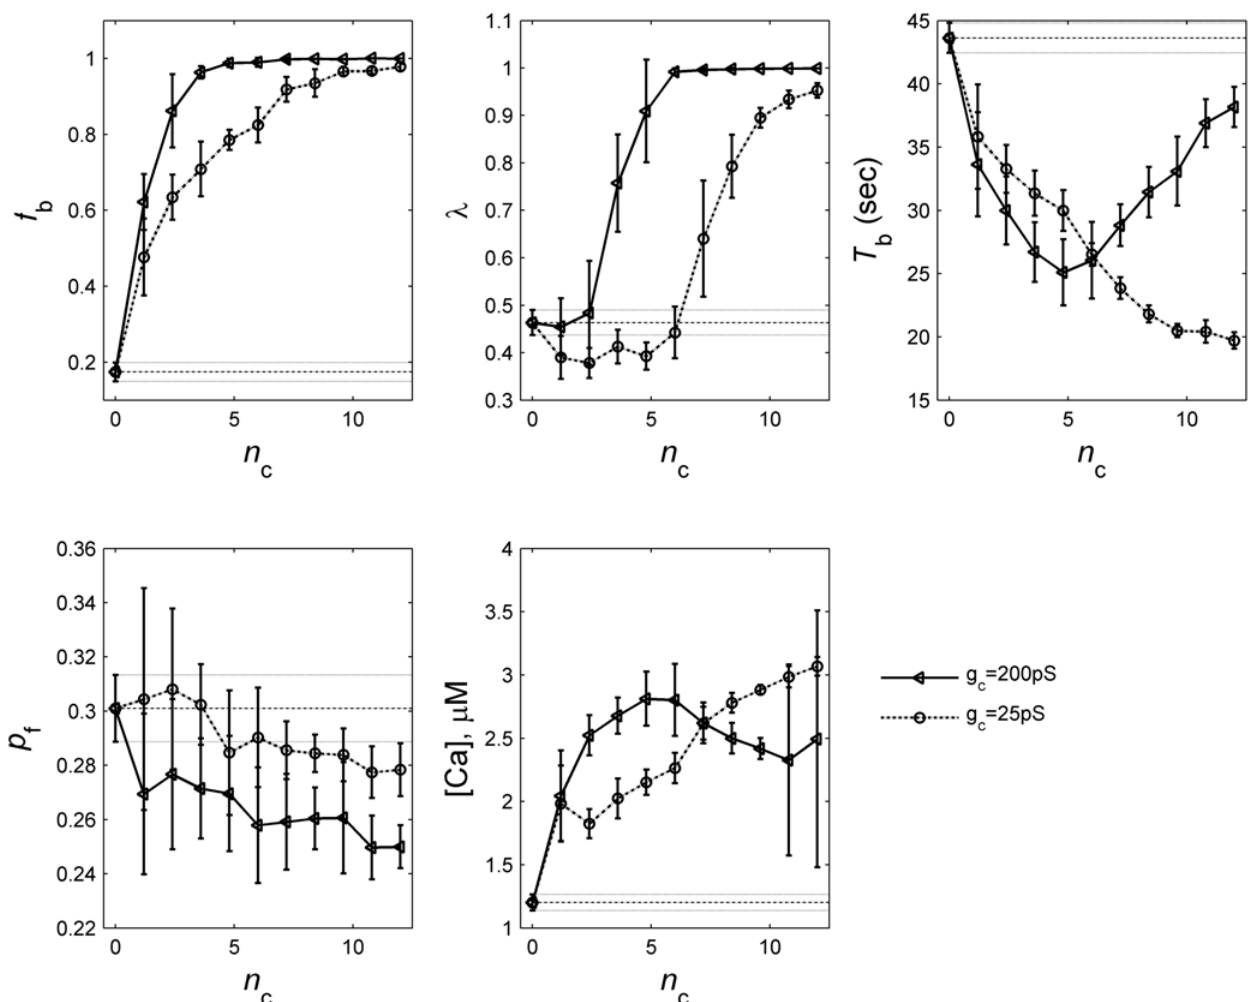
Figure 6. Function of b -cell clusters versusn c . Plotted are results of a HCP-323 cluster. Dashed lines are the basal level values and 2 SD that would be expected from a cluster of un-coupled b -cells